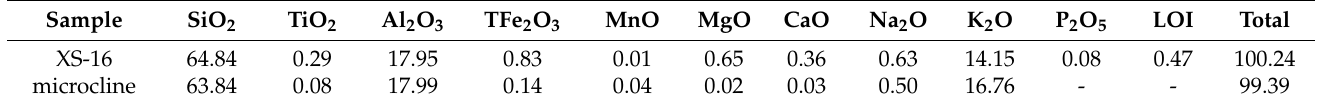
Table 1. The chemical compositions of biotite syenite and microprobe analysis of microcline (wt.%).